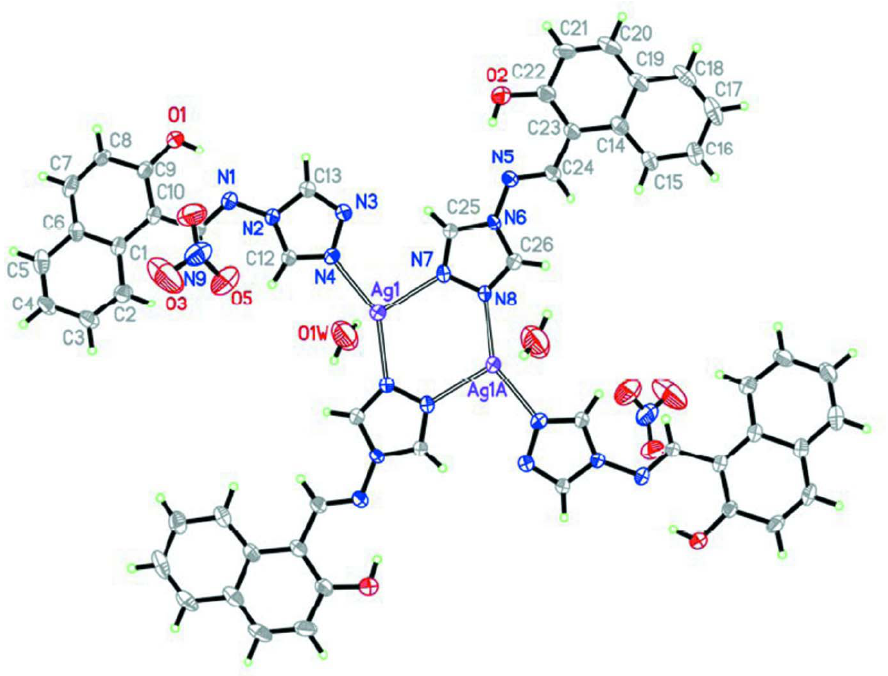
A perspective view of the molecular structure showing the atom-numbering scheme. Displacement ellipsoids are drawn at the 30% probability level. [symmetry code: (A) 2 - x , - y , 2 - z